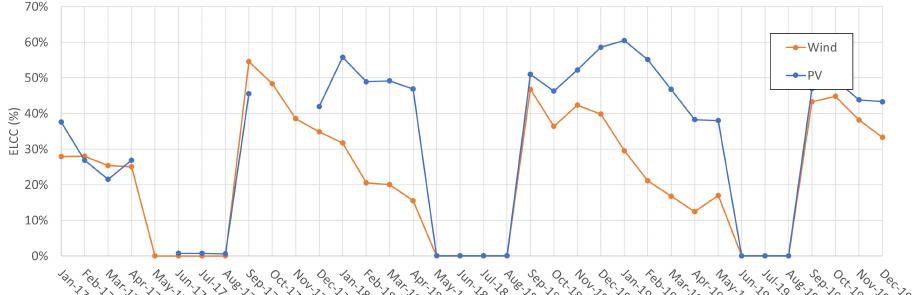
Figure 20. Monthly ELCC in percentages for the SIN calculated based on the monthly installed capacity data.